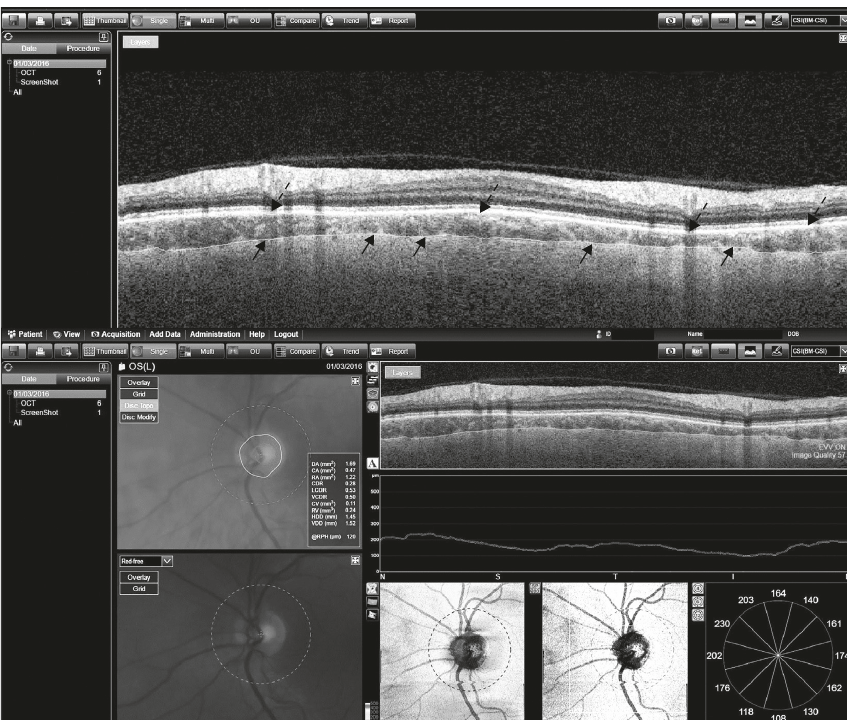
Figure 1: Segmentation of the choroidal plexus of the peripapillary area. Automated segmentation of the peripapillary choroidal plexus and analyzed data provided by Triton OCT in a patient with multiple sclerosis. Arrows indicate the boundaries of the choroidal plexus. Table 1: Macular retinal thickness and macular volume as mea- The ganglion cell layer as measured from the RNFL to sured with swept-source deep range imaging optical coherence the boundaries of the inner nuclear layer (GCL+) was tomography Triton in patients with multiple sclerosis and healthy found to be reduced in the nasal (40.96 µ m in controls vs subjects.